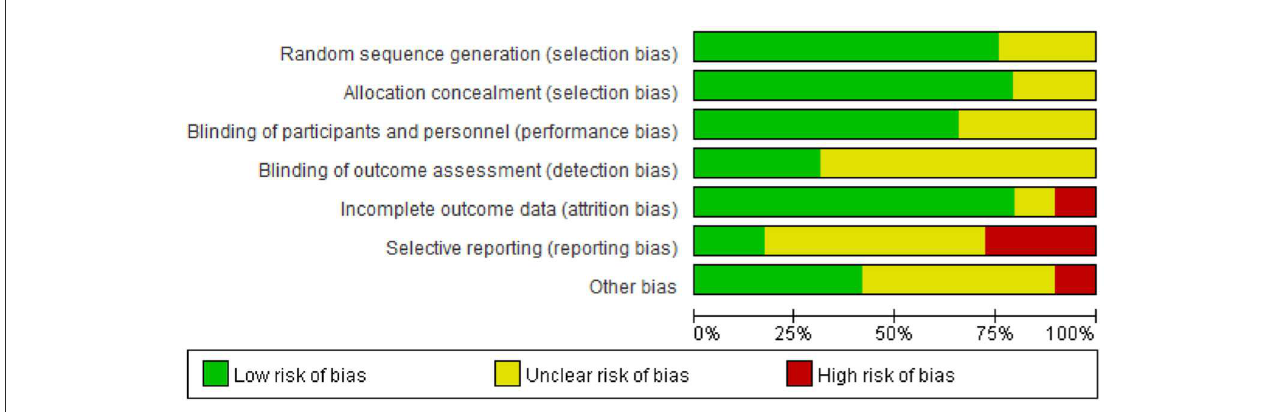
FIGURE2 Risk of bias graph: review authors’ judgements about each risk of bias item presented as percentages across all included studies.